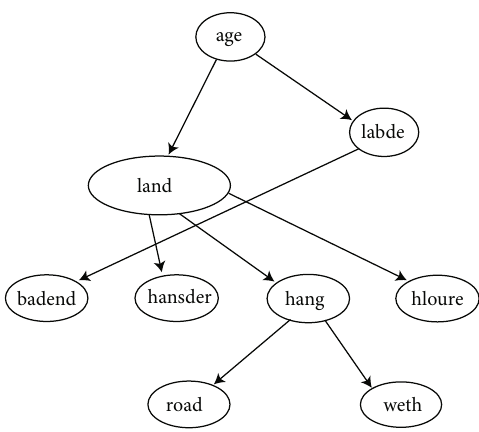
Figure 2: HC algorithm.